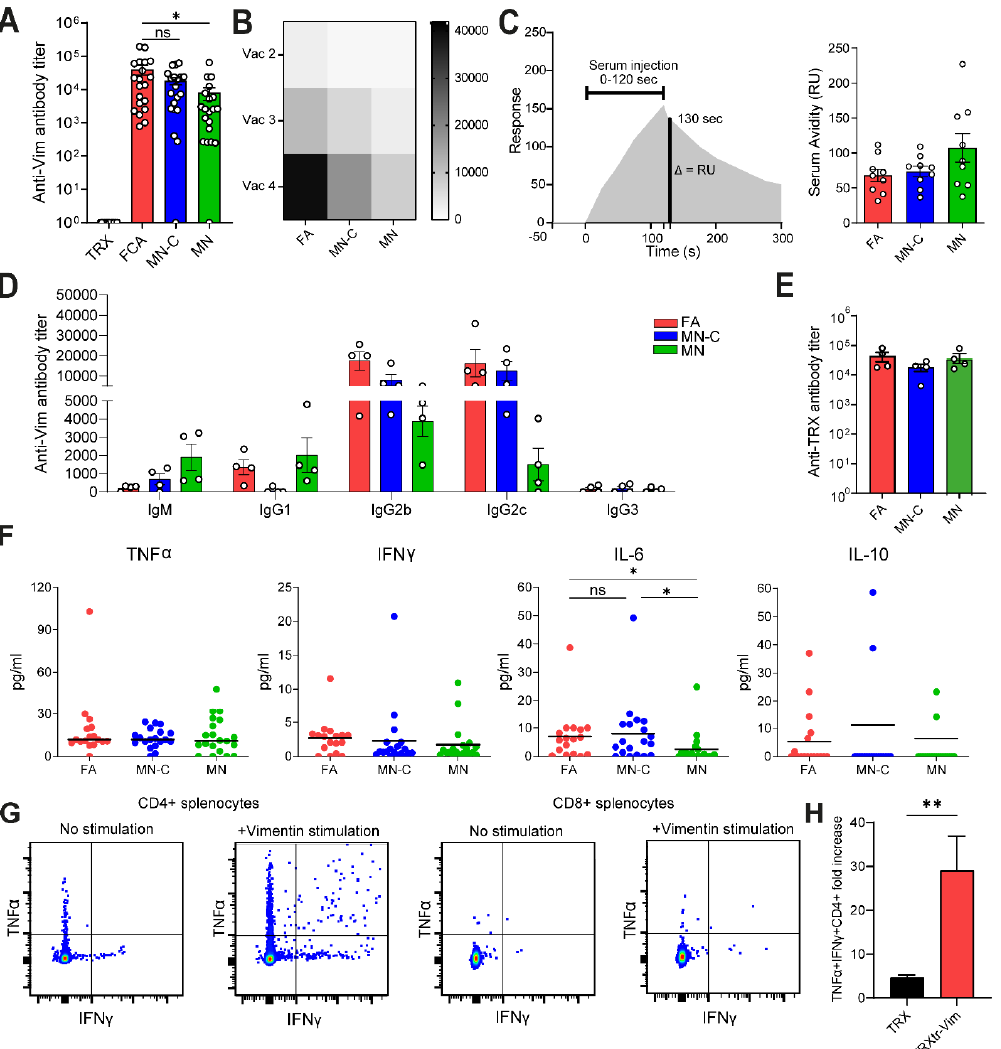
Figure 2. Characterization of the humoral immune response after vaccination with different adjuvant compositions. ( A ) Anti-vimentin total immunoglobulin (Ig) titers for each mouse in serum after the